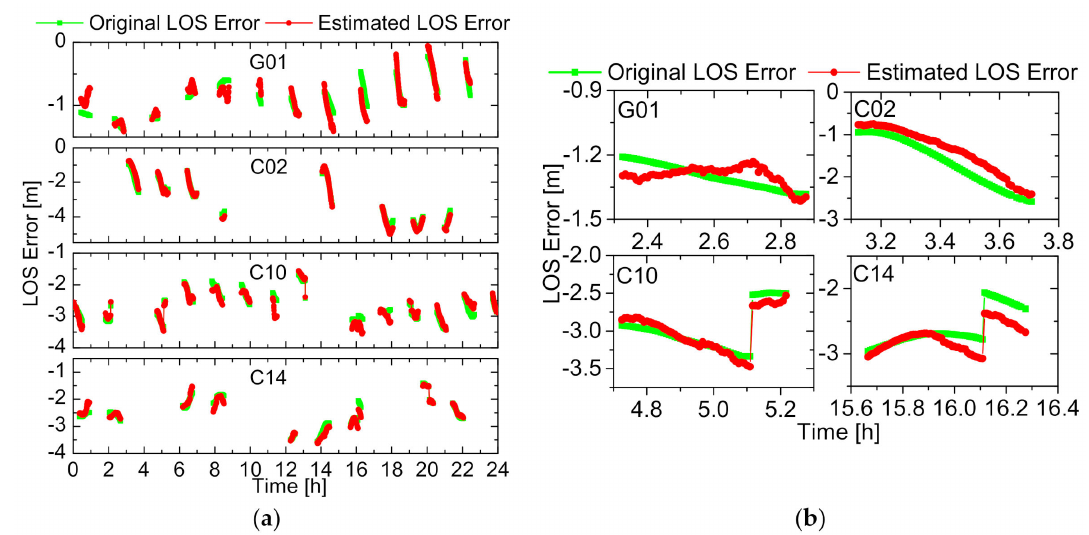
Figure 4. Comparison of the original true and estimated LOS errors: ( a ) the LOS errors caused by the broadcast ephemeris and estimated in pseudo-ambiguity on DOY 71, 2015; ( b ) the original and estimated LOS errors in a tracking arc.